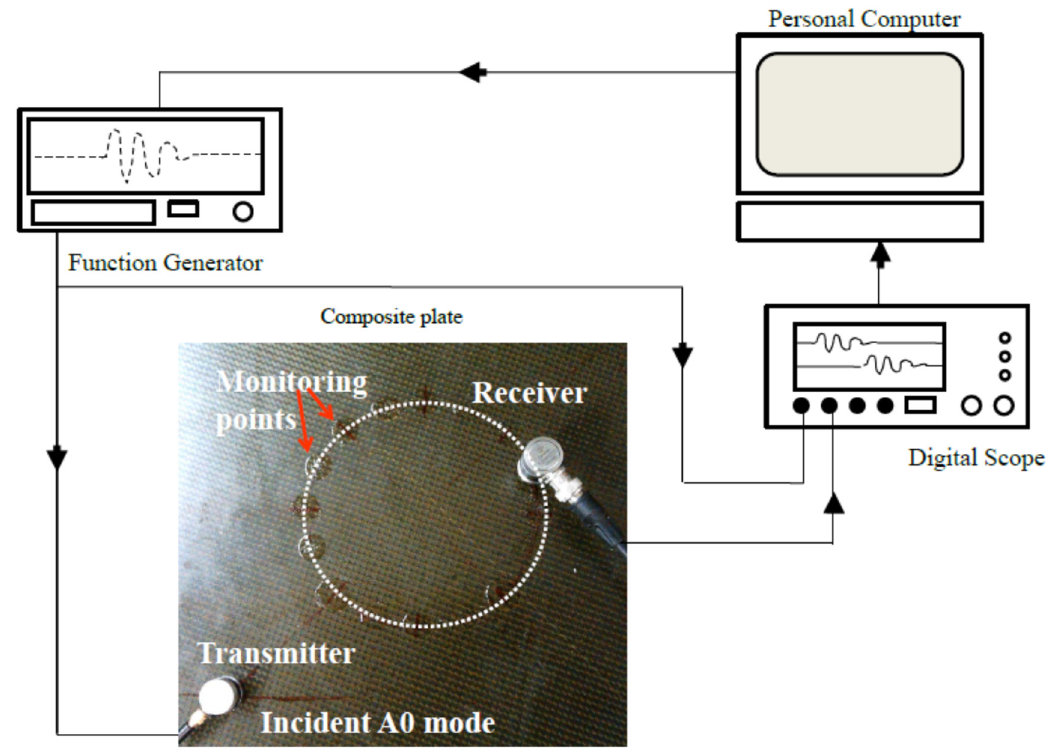
Figure 7. Schematic of the experimental setup for measuring the out-of-plane amplitude of the A 0 mode. It is observed in the phase velocity dispersion curves in Figure 2 that the higher wave mode A 1 starts to appear right after 120 kHz. Accordingly, the excitation frequency of 100 kHz is chosen to avoid the appearance of higher-order Lamb modes. At 100 kHz, the wavelengths of A 0 and S 0 modes are equal to 13.9 mm and 57.7 mm, respectively.